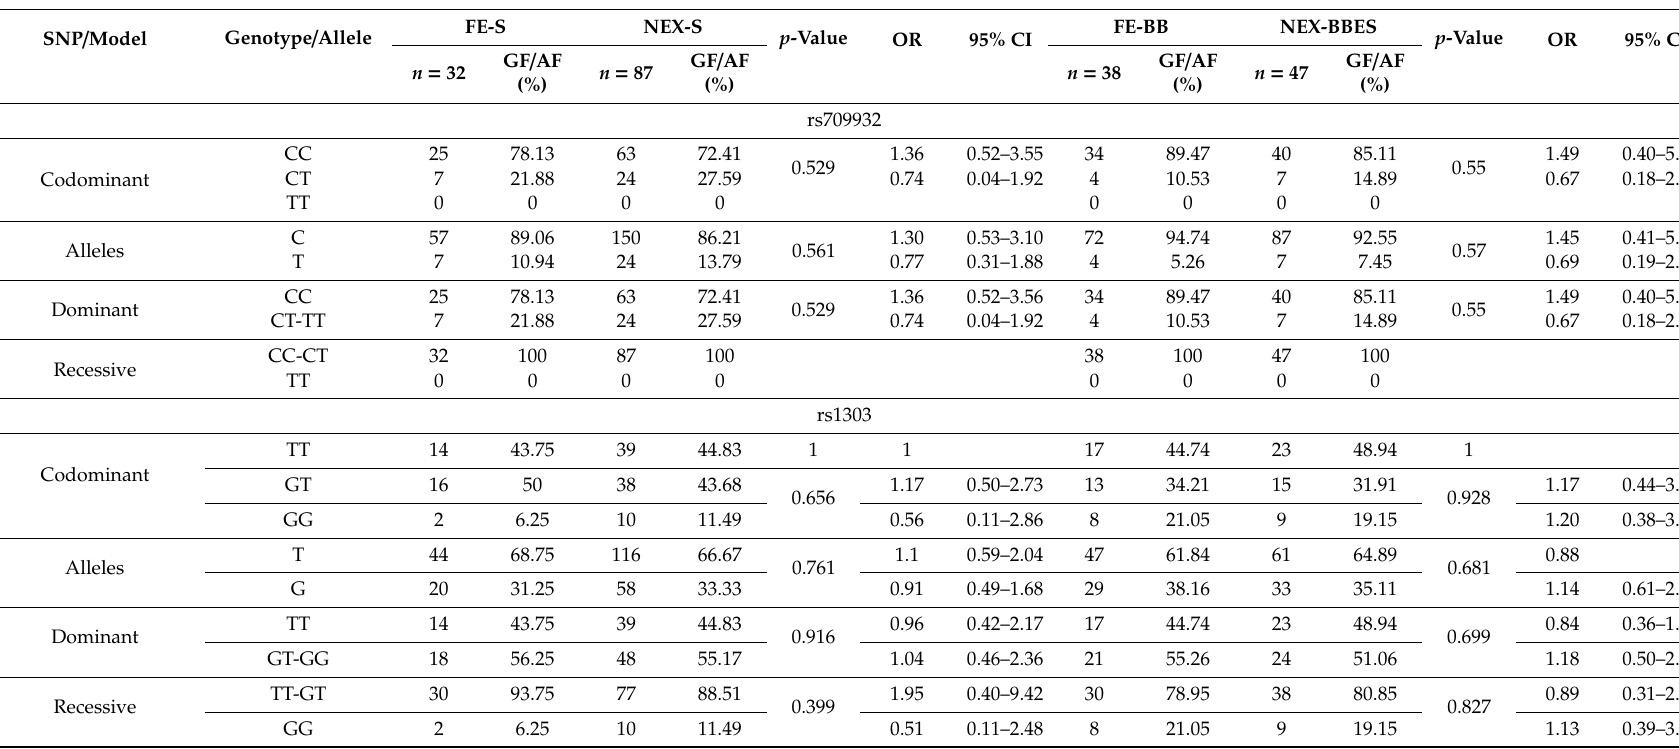
Table 4. Analysis of the association of alleles and genotypes in codominant, dominant, and recessive models between Frequent exacerbators and